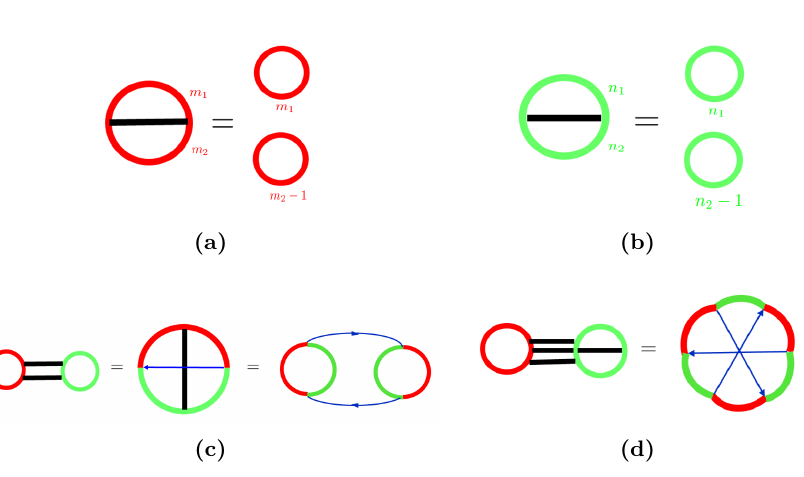
Figure 2. Diagrams of loop operators from ref.